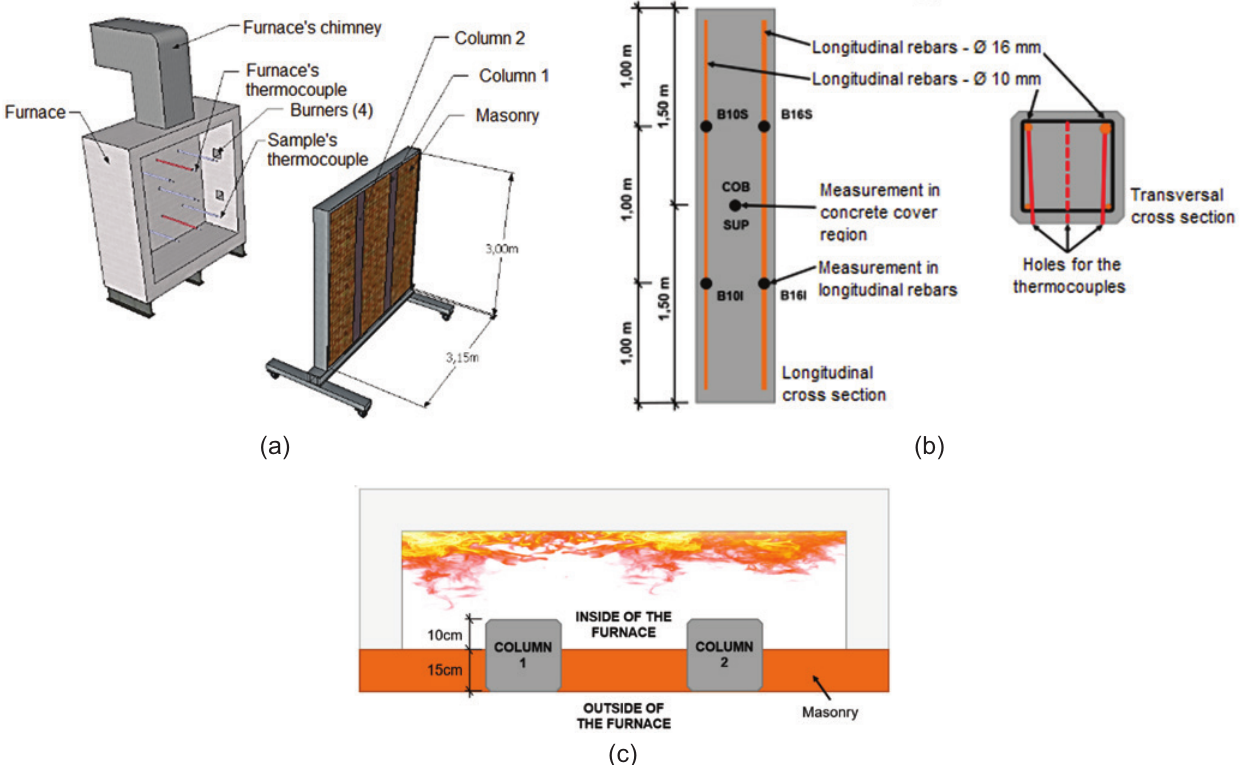
Figure 2 (a) 3D scheme of system installation in the vertical furnace, (b) thermocouple location and (c) system plan